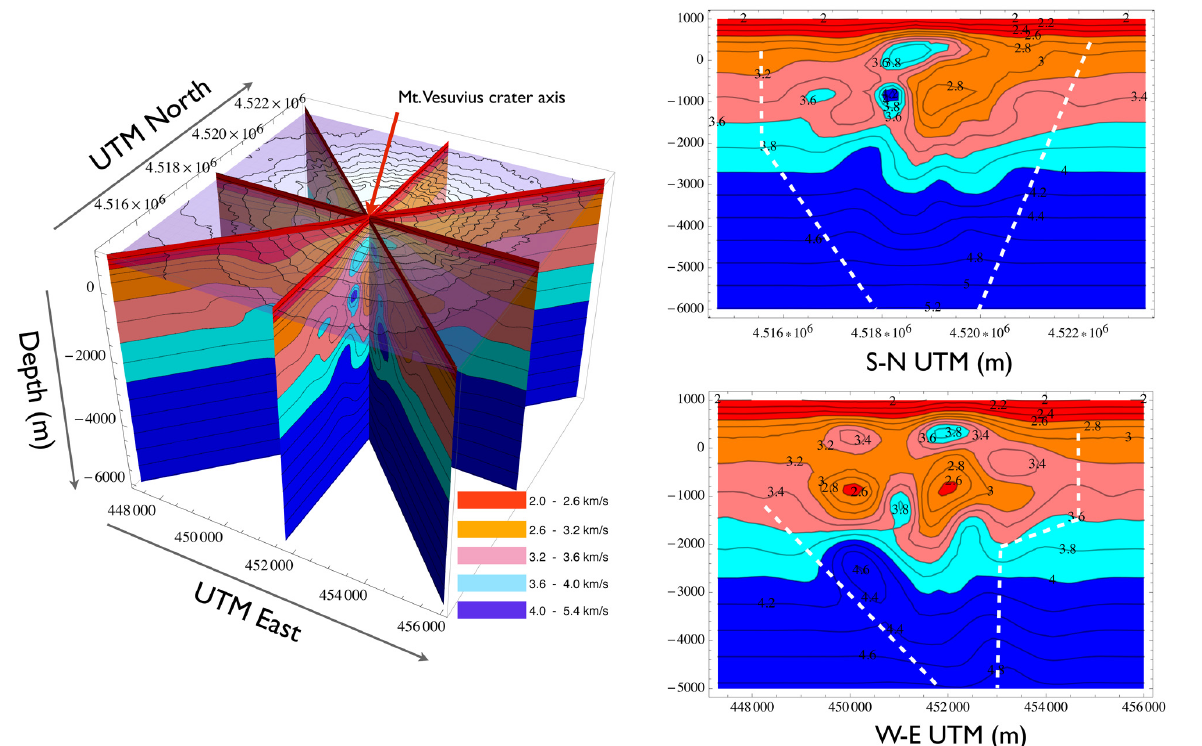
Figure 1. Left panel: 3D plot of interpolated Vp distribution in the earth volume below Mt. Vesuvius, centered at the crater axis. Easting and Northing is in UTM (meters). Depth is negative below the sea level. Mt. Vesuvius map is plotted in transparency at 800 m a.s.l. Right panels: S-N (up) and W-E sections, displaced separately for better clarity. White dashed lines confine the zone with high (300 m) resolution. On the right panels we explicitly report the isoline Vp